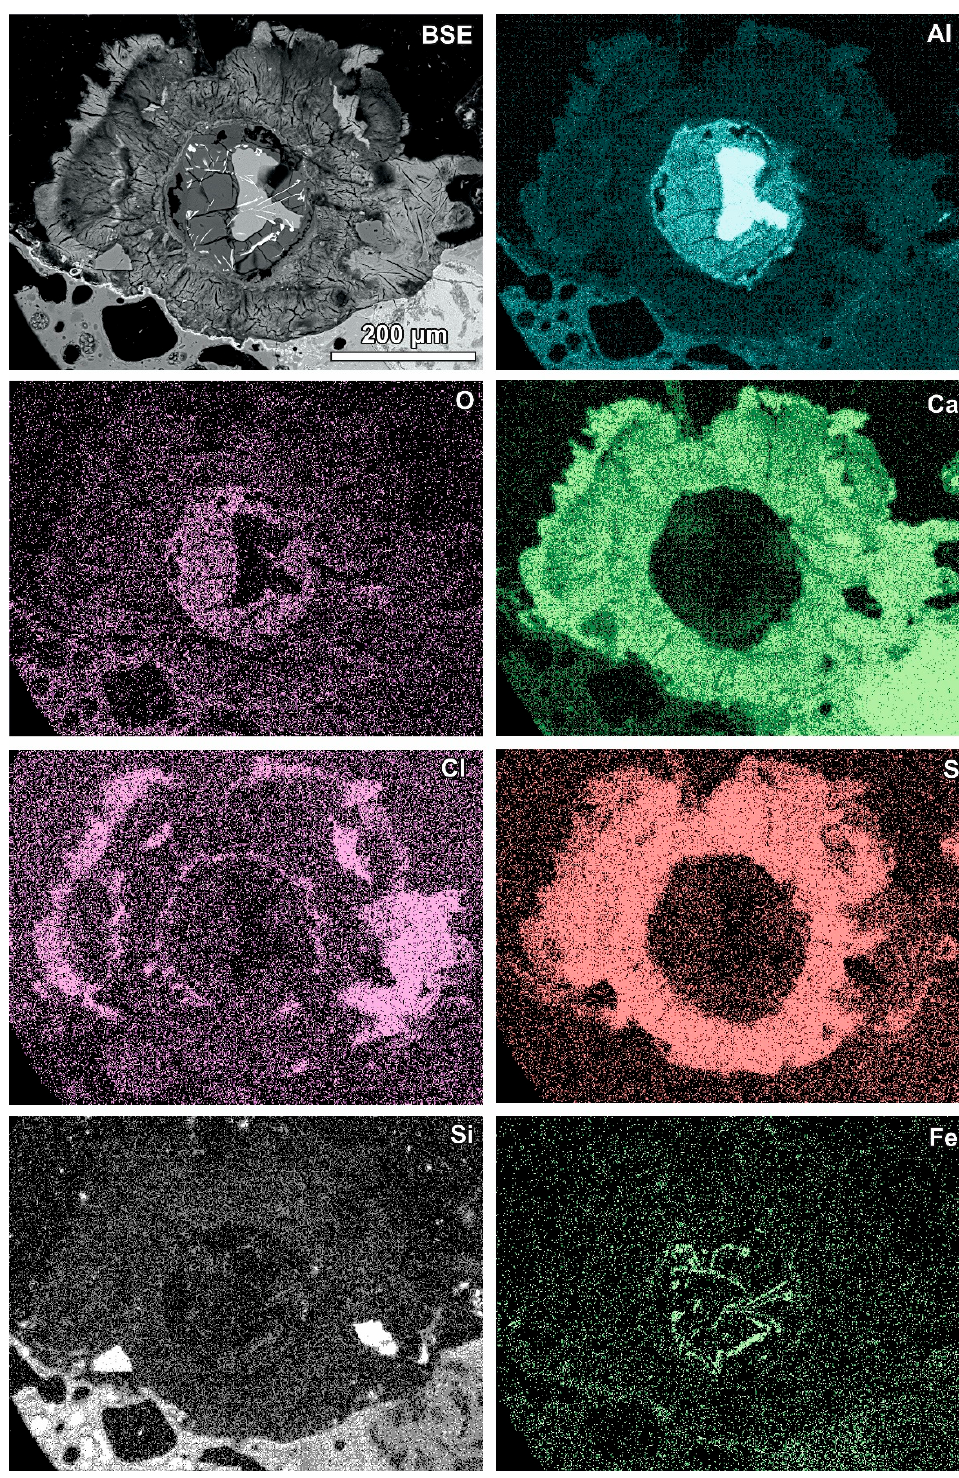
Figure 8. SEM BSE image of the reaction zone and distribution of selected elements—sample RZ10.